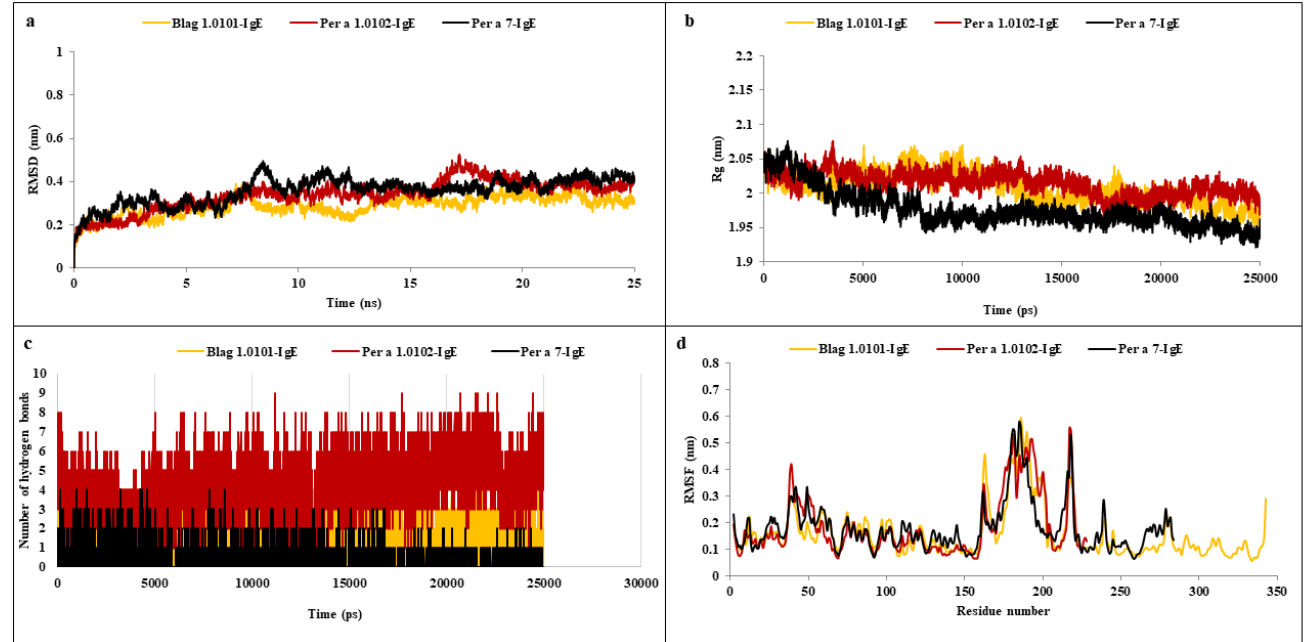
Figure 2. ( a ) RMSD, ( b ) Rg, ( c ) hydrogen bond, and ( d ) RMSF analyses of Blag 1.0101-IgE, Per a 1.0102-IgE, and Per a 7-IgE.